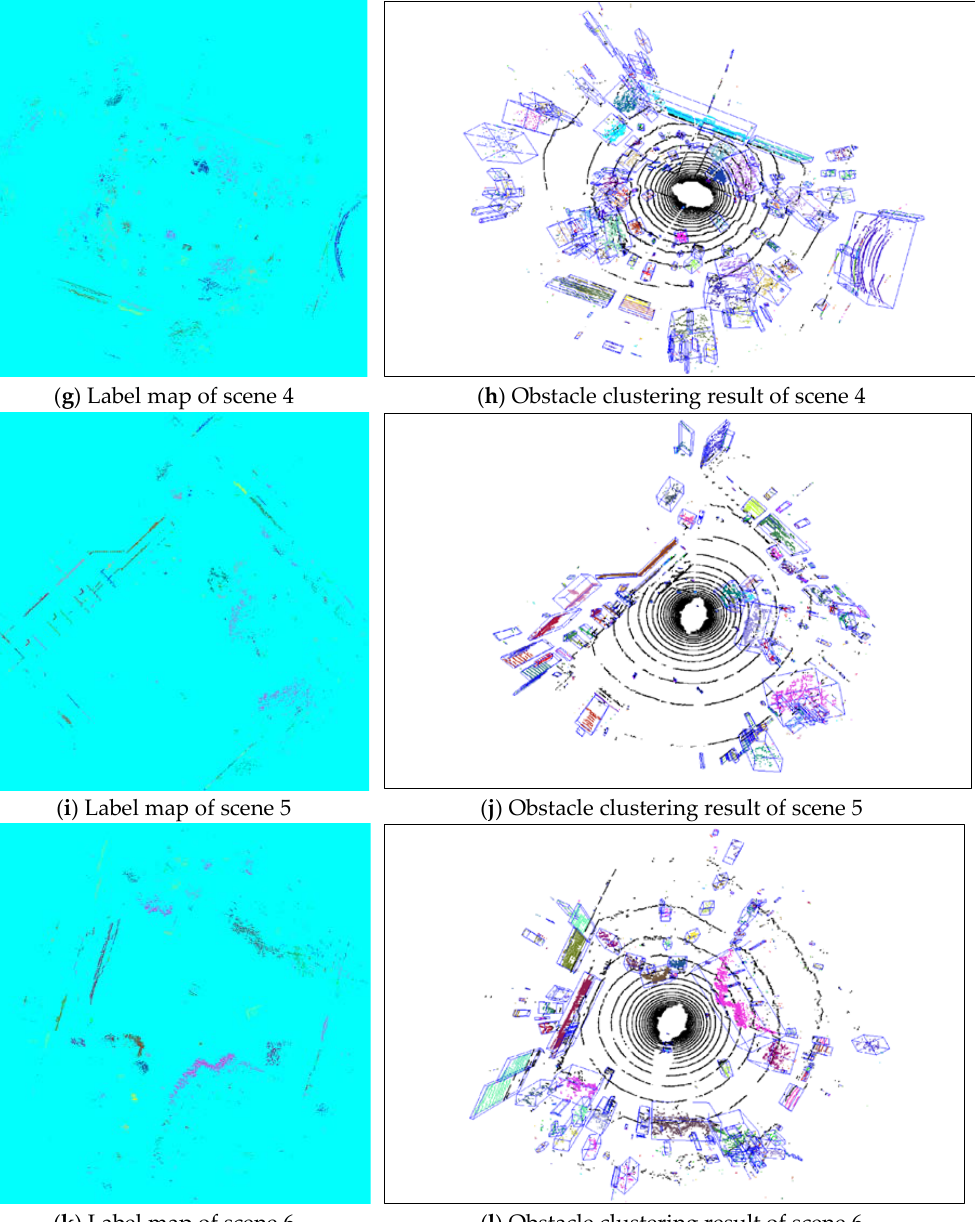
Figure 9. Obstacle clustering results in different scenes: ( a ) clustering result in label map in scene 1 (T junction); ( b ) obstacle clustering result in scene 1 (T junction); ( c ) clustering result in label map in scene 2 (road); ( d ) obstacle clustering result in scene 2 (road); ( e ) clustering result in label map in scene 3 (square); ( f ) obstacle clustering result in scene 3 (square); ( g ) clustering result in label map in scene 4 (multi-trees); ( h ) obstacle clustering result in scene 4 (multi-trees); ( i ) clustering result in label map in scene 5 (multi-person); ( j ) obstacle clustering result in scene 5 (multi-person); ( k ) clustering result in label map in scene 6 (crossroad); ( l ) obstacle clustering result in scene 6